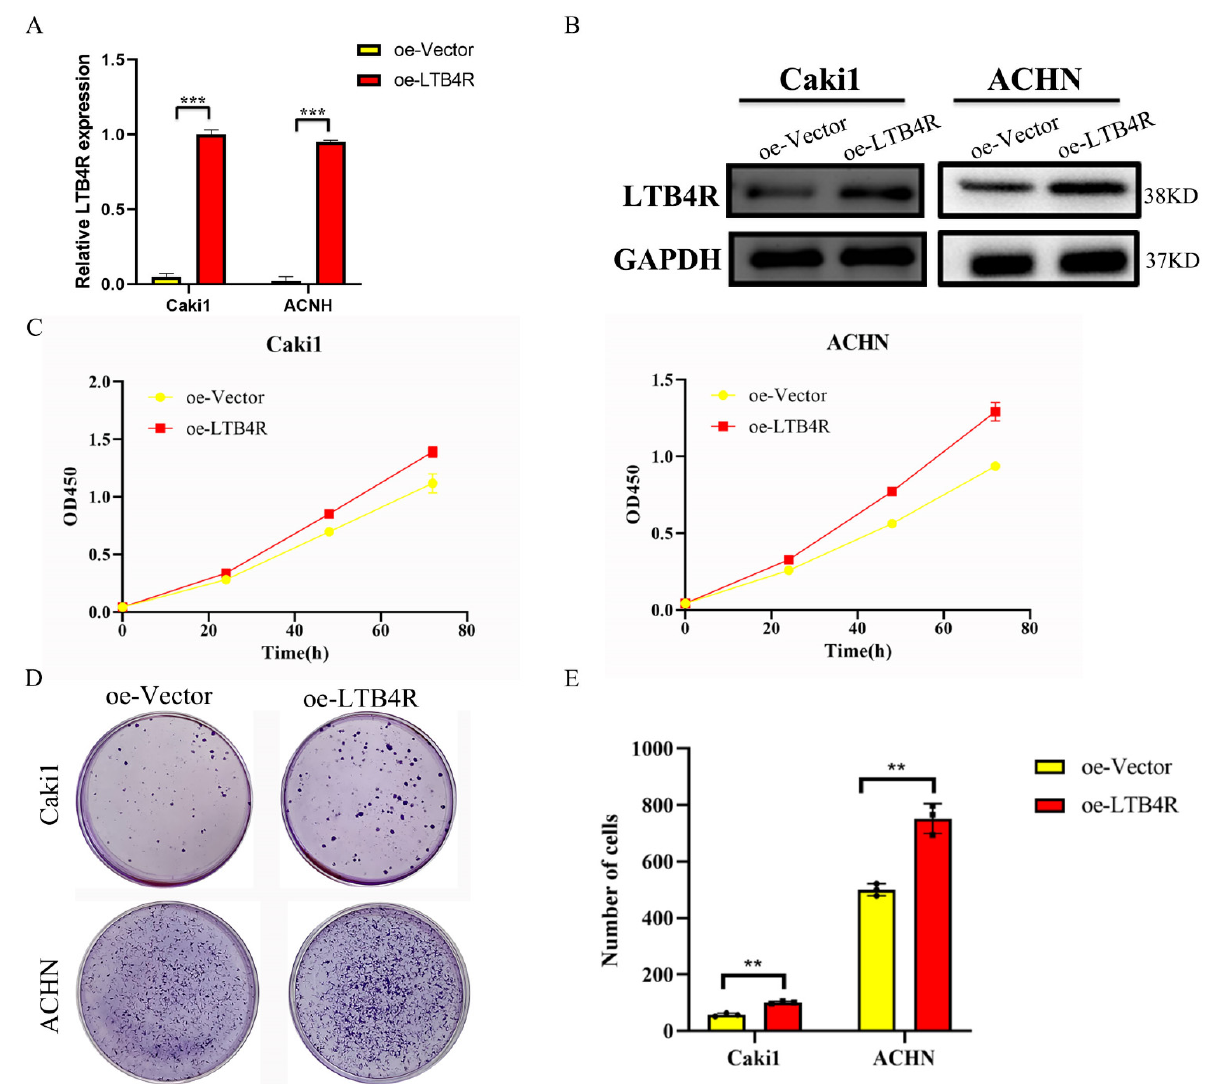
Figure 4. Overexpression of LTB4R promoted proliferation and clone formation of ccRCC cells. ( A ) RT-qPCR detection of LTB4R overexpression efficiency. ( B ) Western blot experiments to verify the overexpression efficiency of LTB4R. ( C ) Overexpression of LTB4R promoted the proliferative capacity of Caki1 and ACHN cells. ( D , E ) Overexpression of LTB4R promoted clone formation of Caki1 and ACHN cells. A 2-tailed t test was used (** p < 0.01, *** p < 0.001).